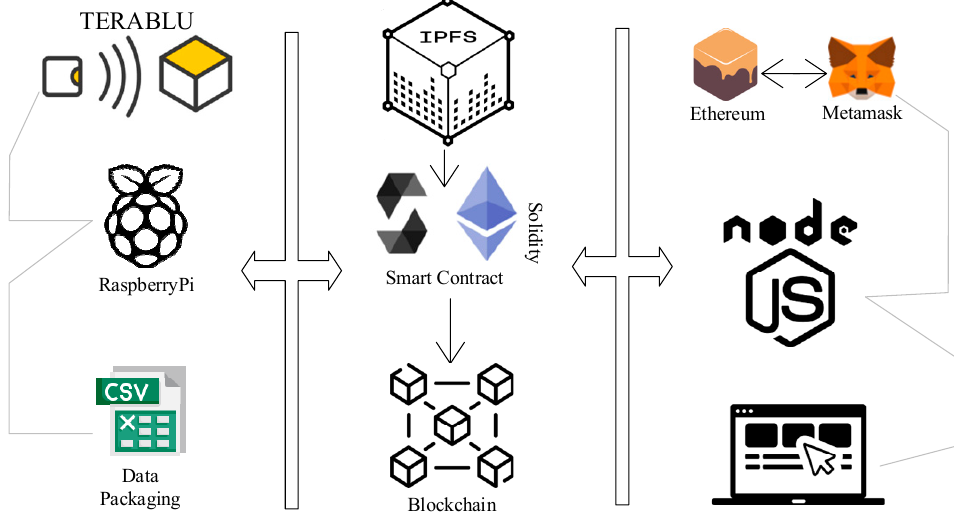
Figure 8. Overview of System Implementation Tools and Technologies.